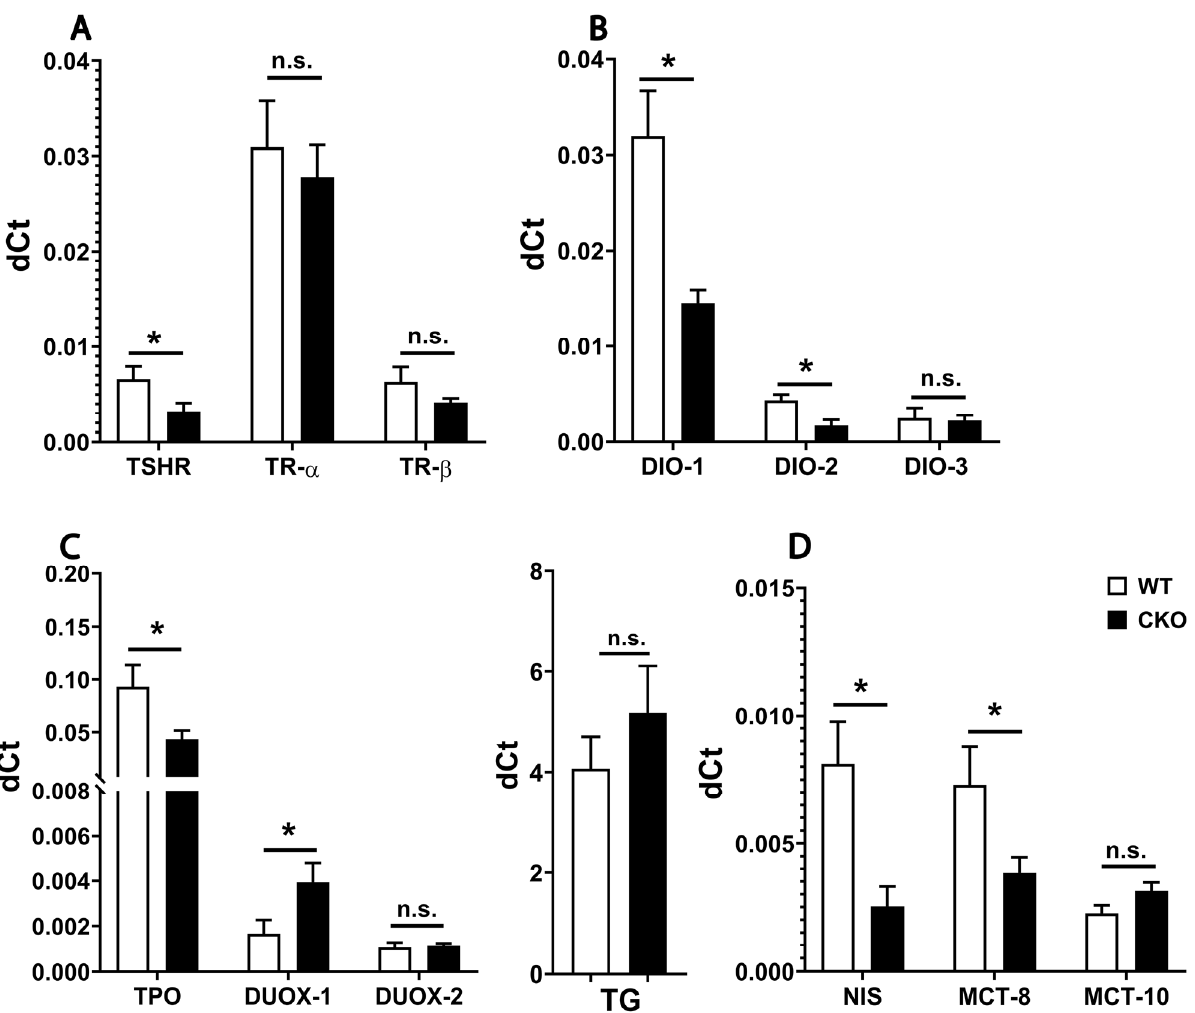
Figure 4. qPCR comparing the expression of specific genes in the thyroid gland between W.T. and CKO mice (8 months old). ( A ) The expression of various receptors. TSH-R showed significant re- duction in CKO. [t (11) = 2.36, p = 0.035 ]. ( B ) The expression of DIO enzymes. DIO-1 showed signif- icant reduction in CKO. [t (7) = 3.17, p = 0.016 ]. DIO-2 showed significant reduction in CKO. [t (8) = 2.95, p = 0.018 ]. ( C ) The expression of genes coding for enzymes involved in thyroid hormone syn- thesis. The expression of TPO was significantly reduced in CKO. [t (13) = 2.40, p = 0.032 ]. The ex- pression of DUOX-1 was significantly reduced in CKO. [t (12) = 2.61, p = 0.023 ]. ( D ) The expression of iodide and thyroid hormone transporters. The expression of NIS was significantly reduced in CKO. [t (13) = 4.09, p < 0.005 ]. The expression of MCT-8 was significantly reduced in CKO. [t (6) = 3.03, p = 0.023 , * p < 0.05 vs. W.T. male mice]. n.s.: nonsignificant. Values are means ± S.E.; n = 4–6 mice/group. t -test was performed to compare CKO and W.T. male mice. Table 2. Summary of changes in hormonal and physiological parameters and gene expression, com- paring CKO and W.T. mice aged 8–9 months old.